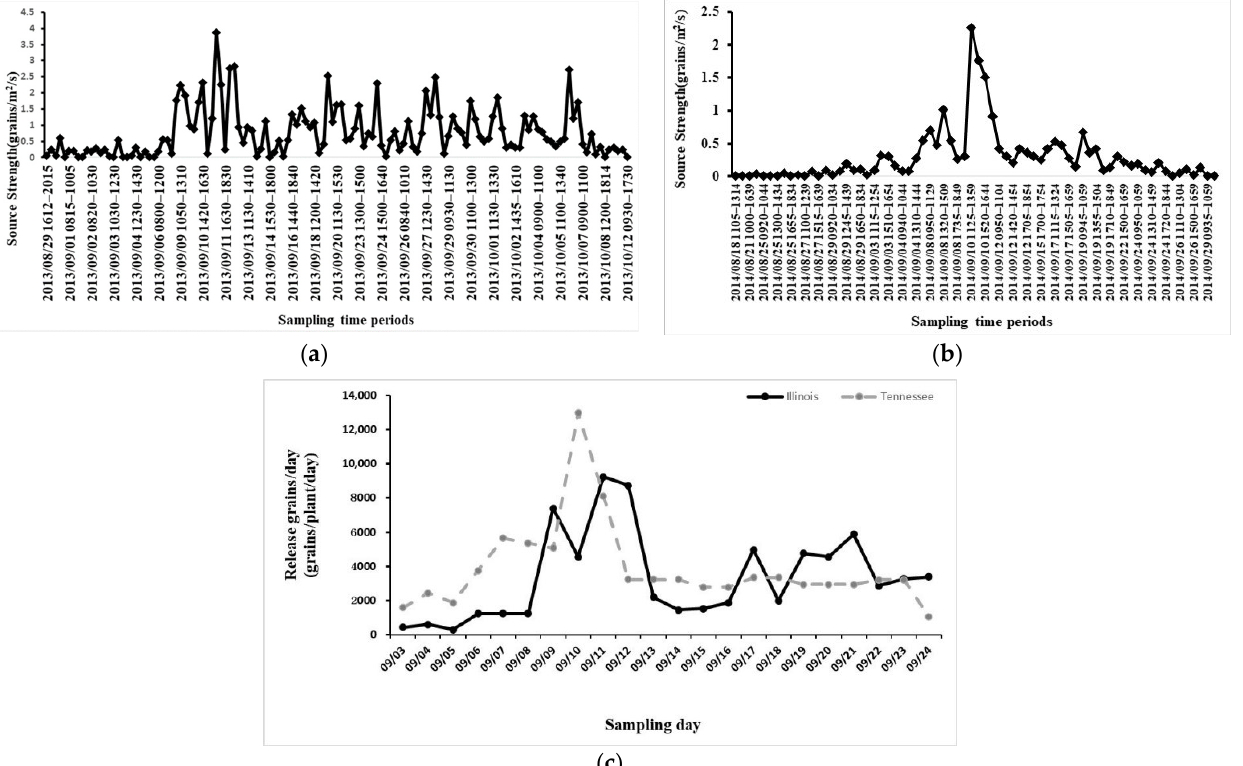
Figure 2. Seasonal seed source strength in the two experiments. ( a ) Hourly average seed source strength measured in the Illinois source field from 29 August 2013 to 12 October 2013; ( b ) hourly average seed source strength measured in the Tennessee source field from 18 August 2014 to 29 September 2014; ( c ) estimated daily released grains per plant (08:00 to 20:00) during the main release period (3 September to 24 September) for Illinois (black solid line) and Tennessee (grey dotted line).